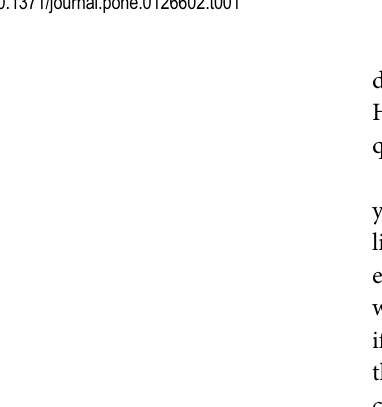
Table 2. Summary of the audiological features of affected members of family SH-01. Patient Gender Test age